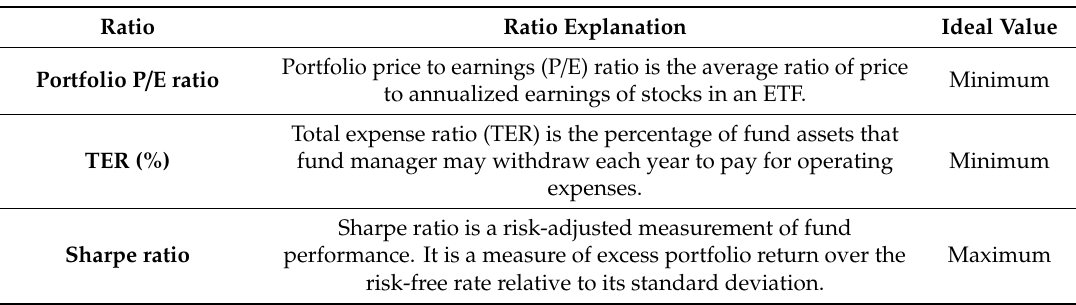
Table 1. Ratio explanations.